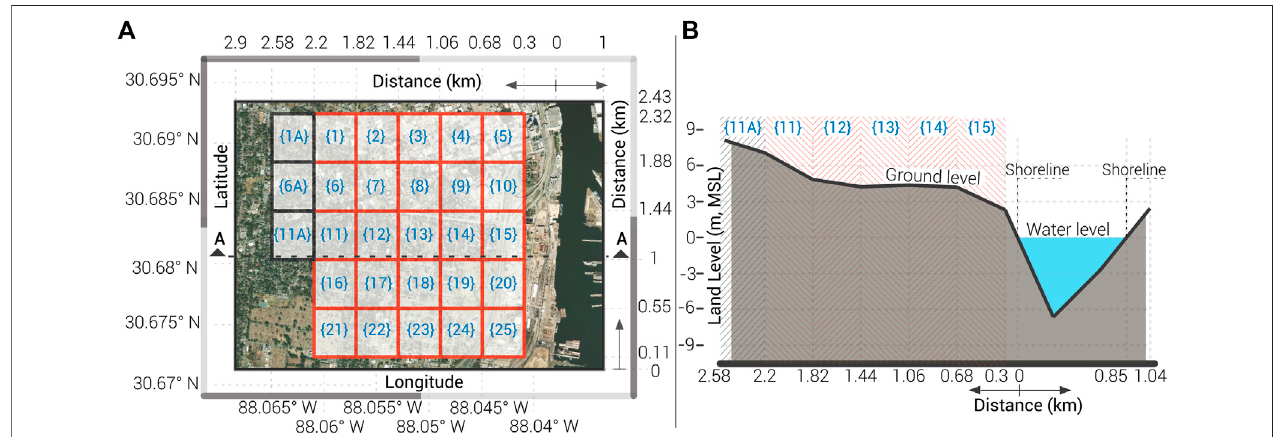
FIGURE 13 | (A) The cells considered in this study analysis and (B) section A-A from (A) showing the cross-section of the land elevations and the Mobile River.